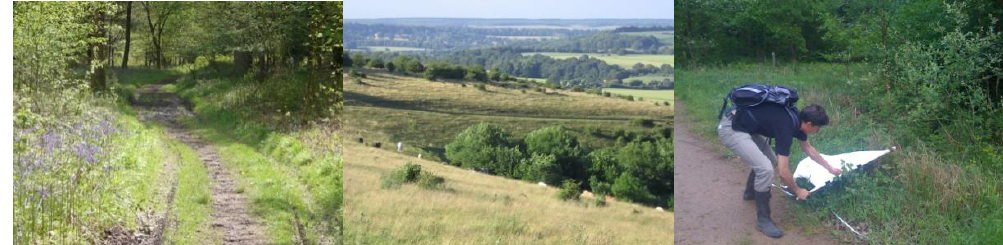
Figure 6. Main habitats for Ixodes ricinus ticks in woodland, grazed grassland. Ticks are collected by blanket dragging vegetation.